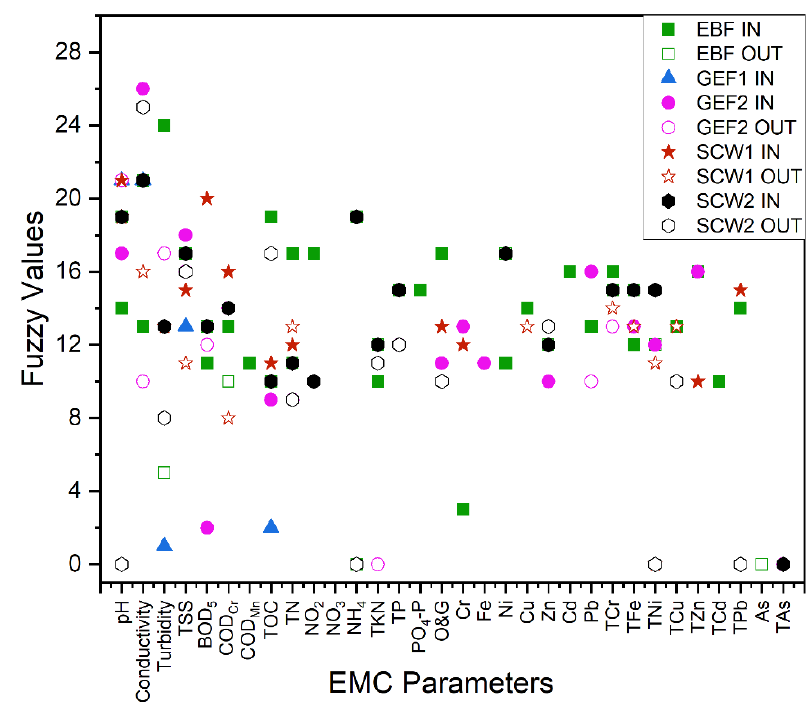
Figure 6. Bioretention EMC parameters and their corresponding fuzzy value.